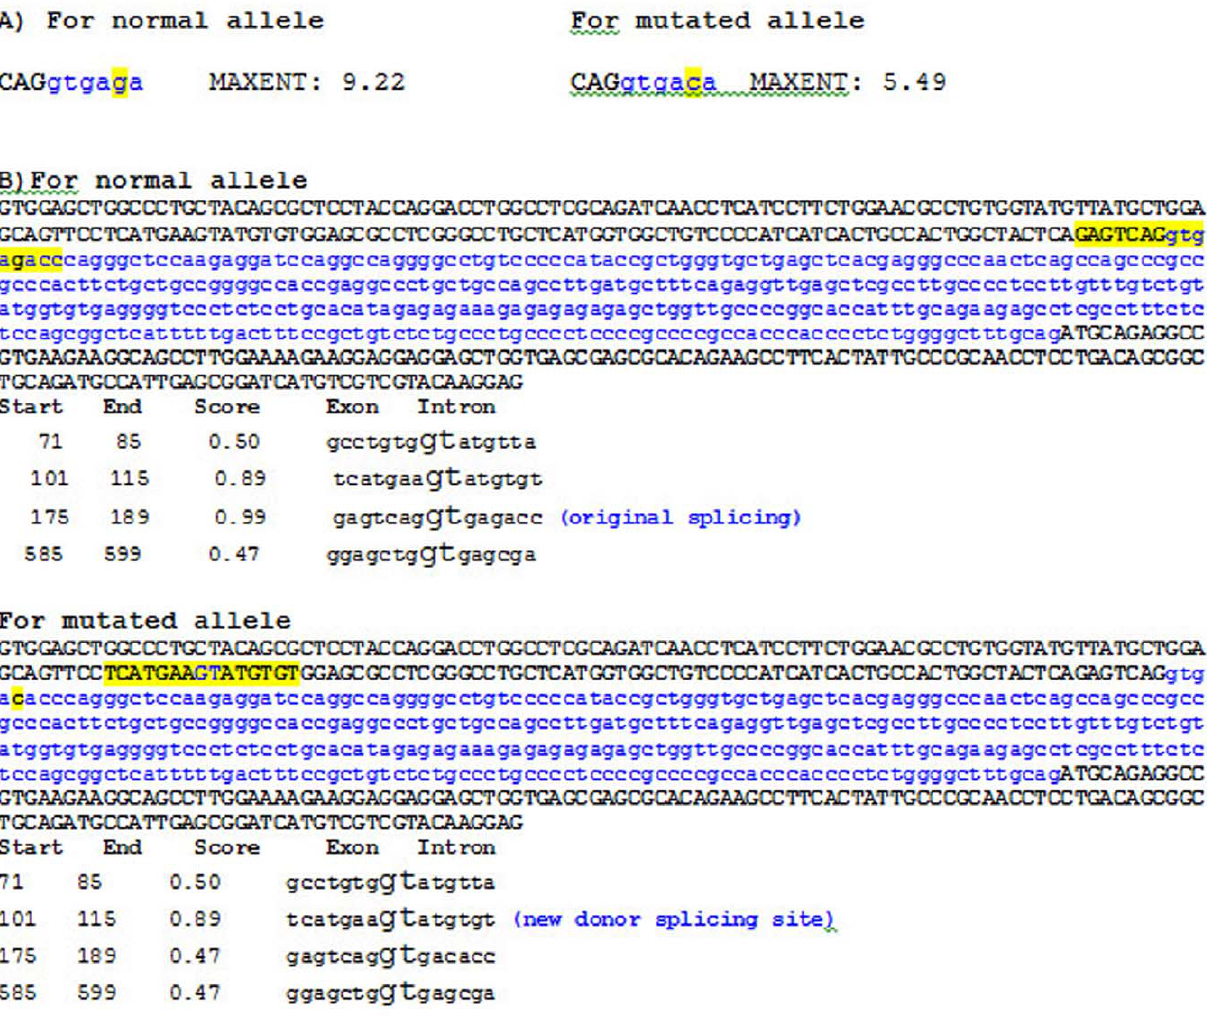
Figure 7. Analysis of the c.1081 + 5G , T intronic mutation using ME and NN programs. A) Numerical result produced by the ME program. Three nucleotides in uppercase correspond to exon 2, in blue intron 2. The normal and changed alleles in position + 5 (c.1081 + 5G . C) are highlighted in yellow. The predicted number for the mutant allele falls four points, which could alter the entropy. B) Analysis of c.1081 + 5G , T intronic mutation with NN program. Exon 2 (181 nucleotides), intron 2 (360) and exon 3 (143) were represented. The nucleotides in uppercase correspond to exon 2 and exon 3, in blue intron 2. For the normal allele: the site of splice original is highlighted in yellow. For the mutated allele: the change from g to c seems to produce the loss of the normal recognition splice site and there is an 89% chance to recognize a cryptic donor splice site located within exon 2. This sequence is highlighted in yellow.